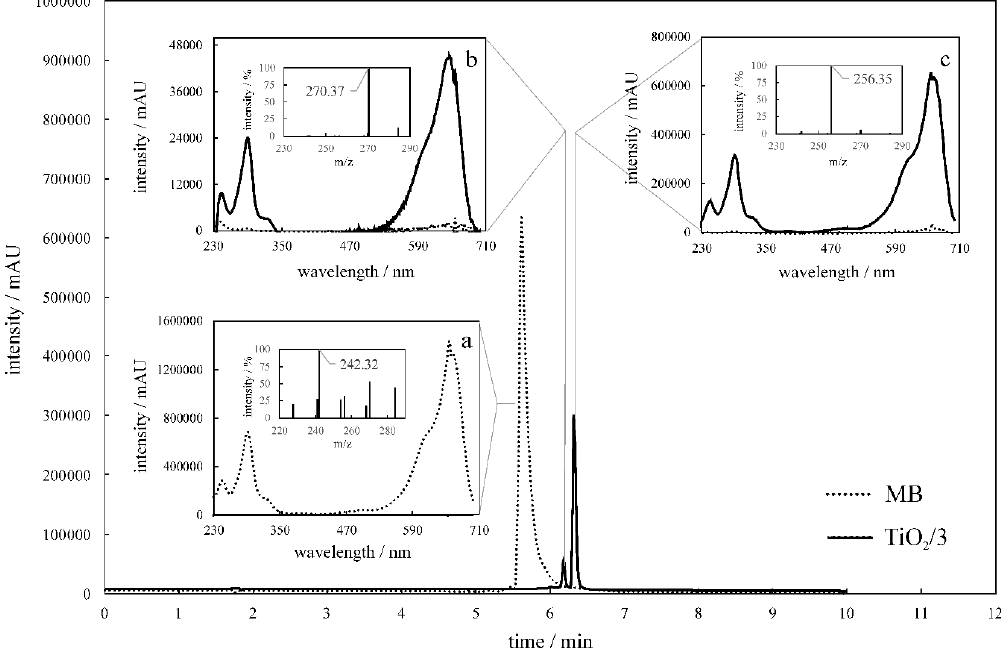
Figure 11. The chromatogram of the initial methylene blue (MB) solution ( dotted line ) and after 2 h of photocatalytic treatment ( solid line ) with TiO 2 / 3 recorded at 610 nm. Absorption spectra corresponding to the peaks are registered in the chromatogram at 5.61 ( a ), 6.20 ( b ), and 6.34 min ( c ). Insets are the mass spectra registered at the respective retention times.